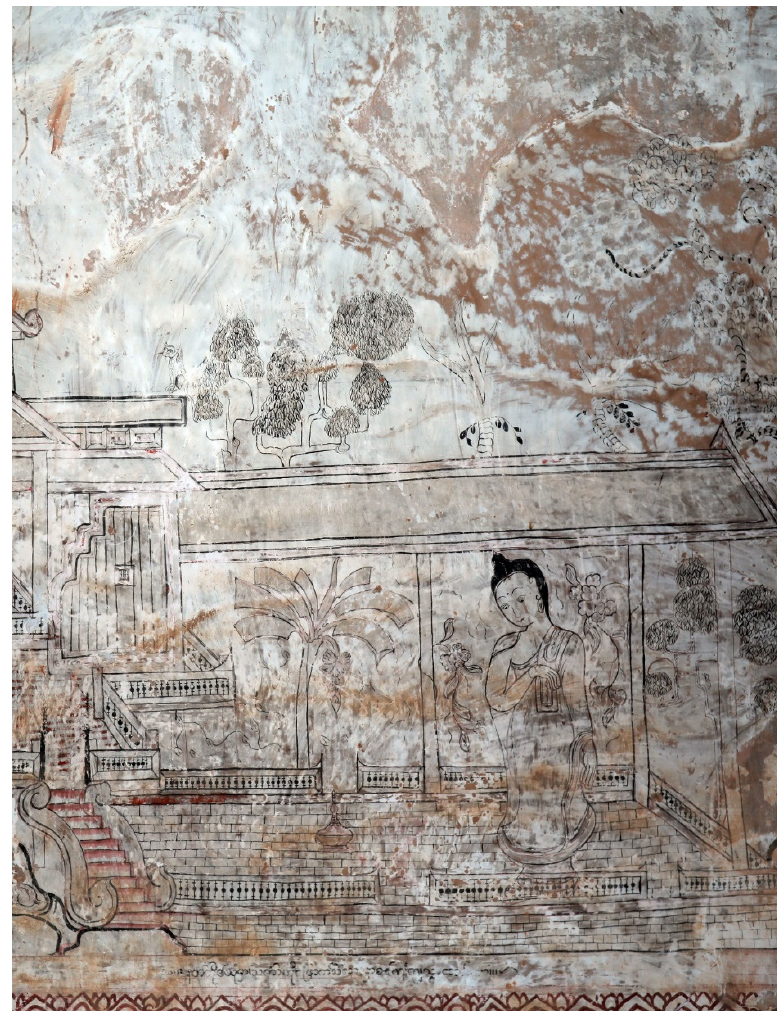
Figure 4. The Buddha walking along a cloistered path, the Third Week, Sulamani temple, Bagan.